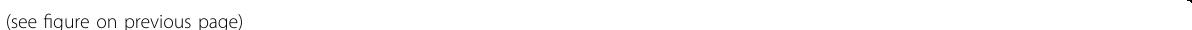
Fig. 3 Changes in peripheral immune cell type and subtype compositions as well as gene expression before and 28 days after the 1st inoculation. a Cell-type UMAP representation of all merged samples. In total, 22 cell types were identi fi ed by cell-type-speci fi c gene expression signatures. In total, 188,886 cells were depicted. b Dot plot for cell-type-speci fi c signature genes. Color scale indicated expression levels and point size represented the percentage of cells per cluster/subtype expressing the corresponding gene. c UMAP representation representing cells before (blue) and after (orange) vaccination. d Heatmap of correlation amongst pseudo-bulk samples. e Percentages of speci fi c immune cell subtypes in total PBMCs from each individual before and after vaccination. Box plot depicted sample distribution. Blue boxes represented samples before, and orange, after vaccination. P values were based on the Wilcoxon test for comparisons between groups before and after vaccination. f Box plots showed changes before and after vaccination in monocyte content from scRNA-seq data (left panel) and clinical laboratory measures (right panel). g Box plots showed changes in CD4 + , CD8 + T-cell contents as well as lymphocyte (T + B + NK) contents before and after vaccination from scRNA- seq data (left 3 panels) and laboratory tests (right panel). h DEGs identi fi ed by pseudo-bulk samples before and after vaccination. i Overrepresentation analysis of HALLMARK gene sets from MSigDB demonstrating different immunological features before and after